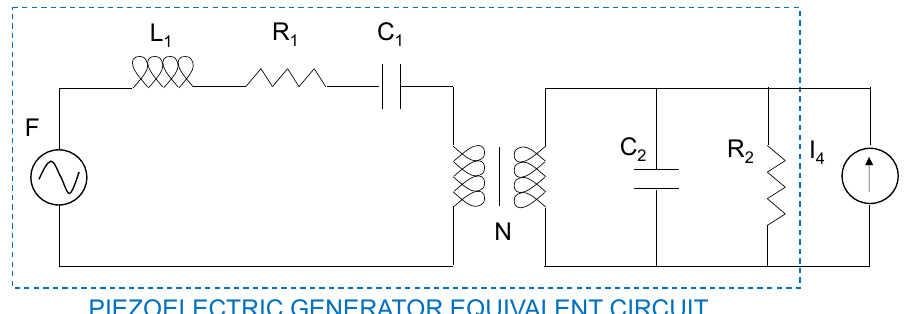
Figure 2. Piezoelectric generator equivalent circuit used to obtain the output voltage in a current source load situation.